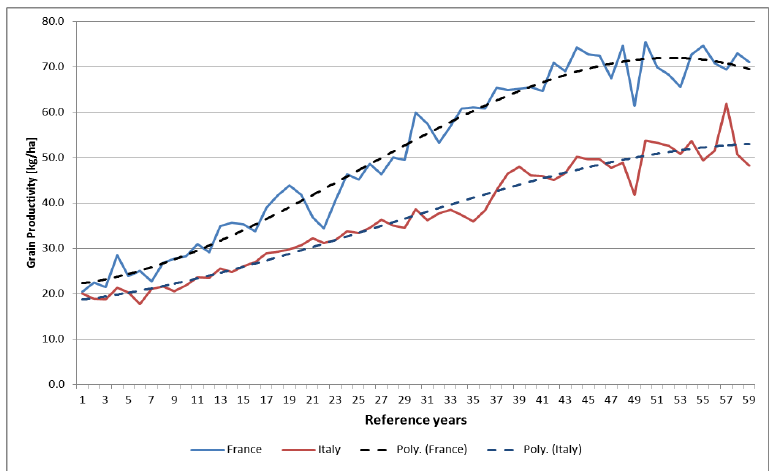
Figure 2. Cereals yield evolution. Source: authors’ own computation based on [56].